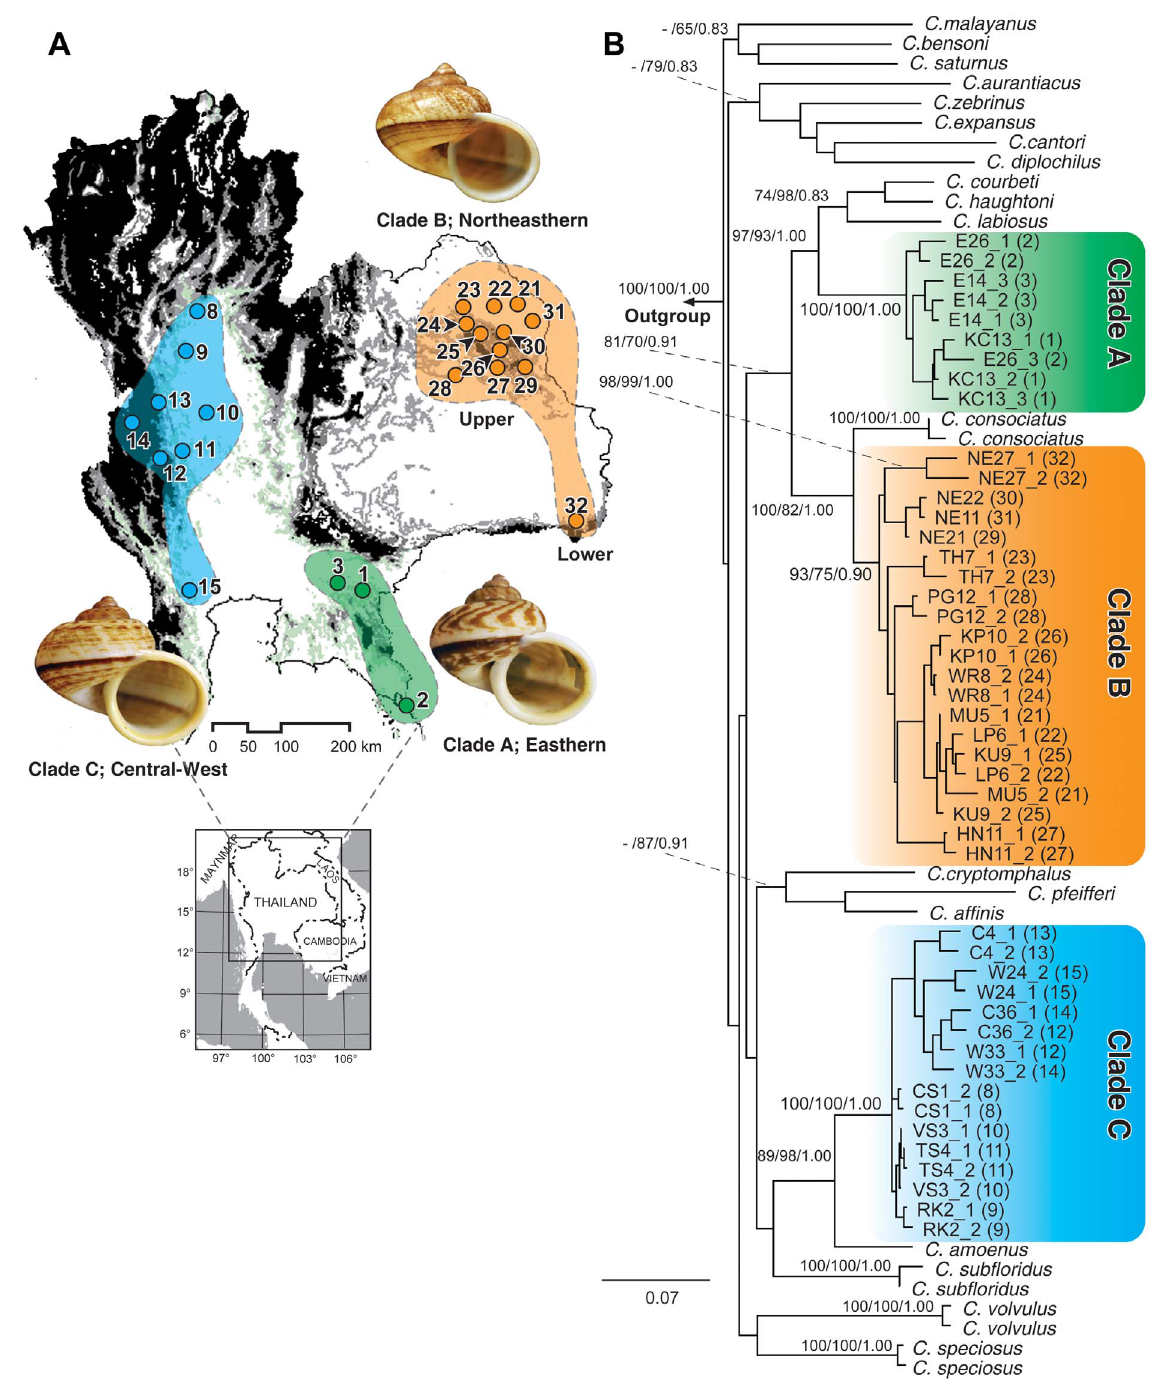
Figure 1. (A) Location of Cyclophorus fulguratus species complex sampling sites in Thailand. The numbered sample sites are detailed in Table 1. (B) Maximum-likelihood phylogenetic tree of the Cyclophorus fulguratus species complex and related species constructed using 2146 nucleotide sites of the concatenated 18S, 28S, 16S and COI genes. Bootstrap support values (when . 65%) and posterior probabilities for individual nodes are shown on the tree (based on NJ/ML/BI methods). doi:10.1371/journal.pone.0109785.g001 tree. The tree topology from a species tree based on concatenated BI methods. Analyses were run with unlinked substitution model sequences of 18S, 28S, 16S and COI genes generated from and clock model parameters (using same settings as for gene tree *BEAST [44], part of the BEAST v1.6.1 package [45], was used as analyses). The Yule process was performed as the species tree a guide tree. The species trees (Fig. 2) were calculated for the C. prior. The two independent runs with a MCMC chain length of 1 6 10 7 each were conducted, sampling every 1000 generations. fulguratus –complex using the same models as used in the ML and